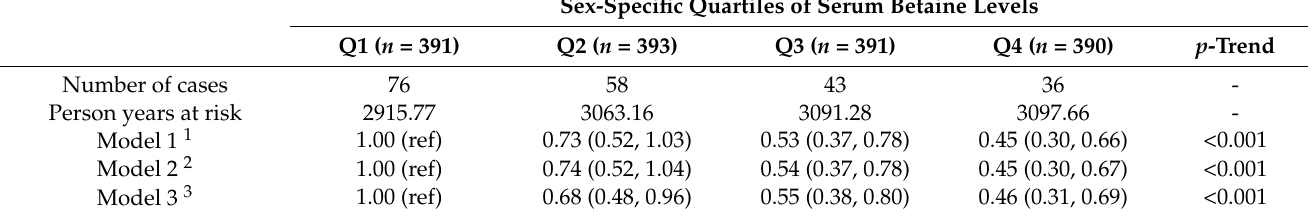
Table 2. Hazard ratios (HRs) and 95% confidence intervals (CIs) of type 2 diabetes according to sex-specific quartiles of serum level of betaine ( n = 1565).